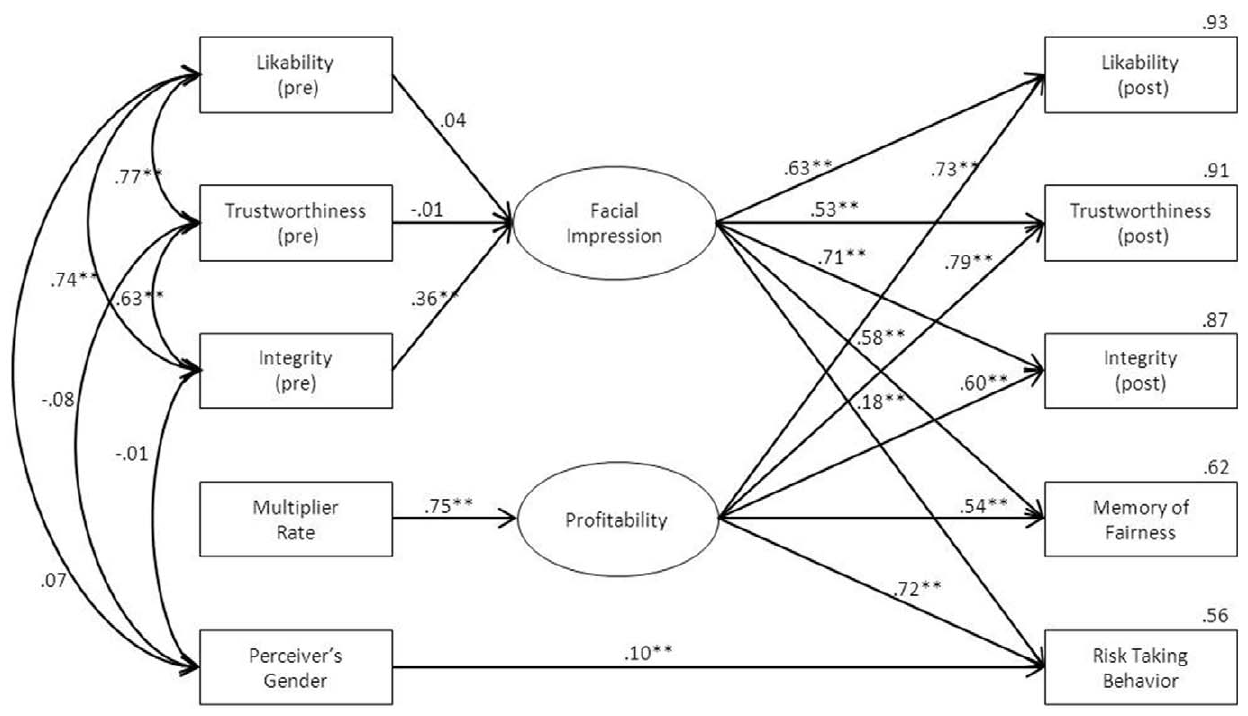
Figure 4. Final model of structure equation models of relationships among MR, profitability and other variables on all partner judgments. * p , 0.05, ** p , 0.01.